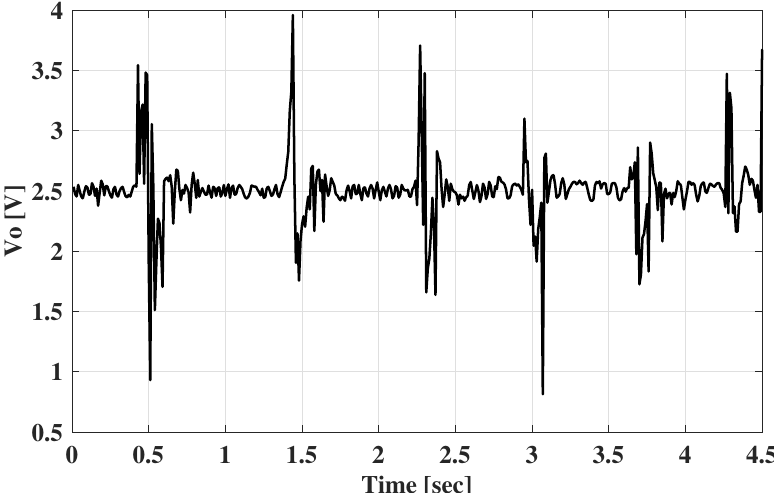
Figure 12. The amplified EMG signals acquired by the DAQ